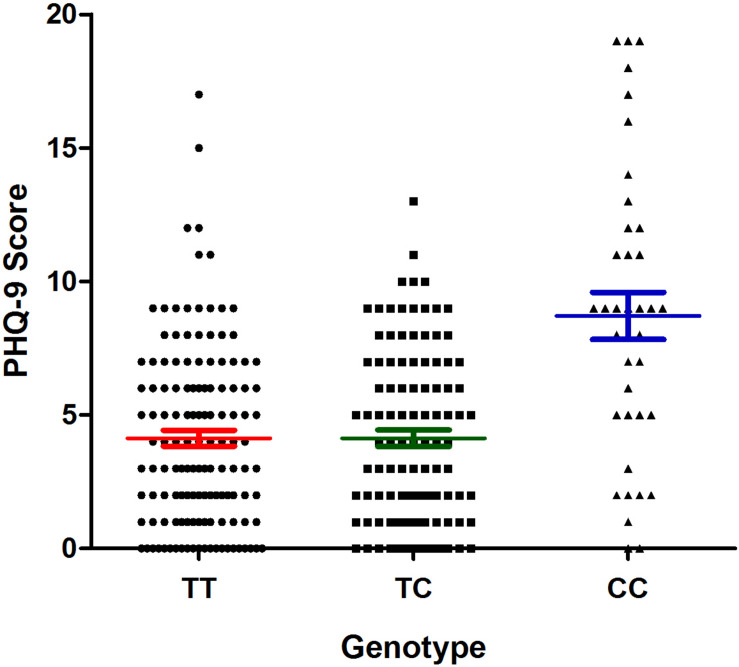
Association of apelin receptor (APLNR) rs9943582 polymorphism with PHQ-9 scores in coronary heart disease (CHD) patients with comorbid depression. The filled circle means TT genotype carriers, the filled square means TC genotype carriers and the filled triangle means the CC genotype carriers. The red lines mean the mean ± SD of PHQ-9 score of TT group, the green lines mean the mean ± SD of PHQ-9 score of the TC group, and the blue lines mean the mean ± SD of the PHQ-9 score of the CC group.